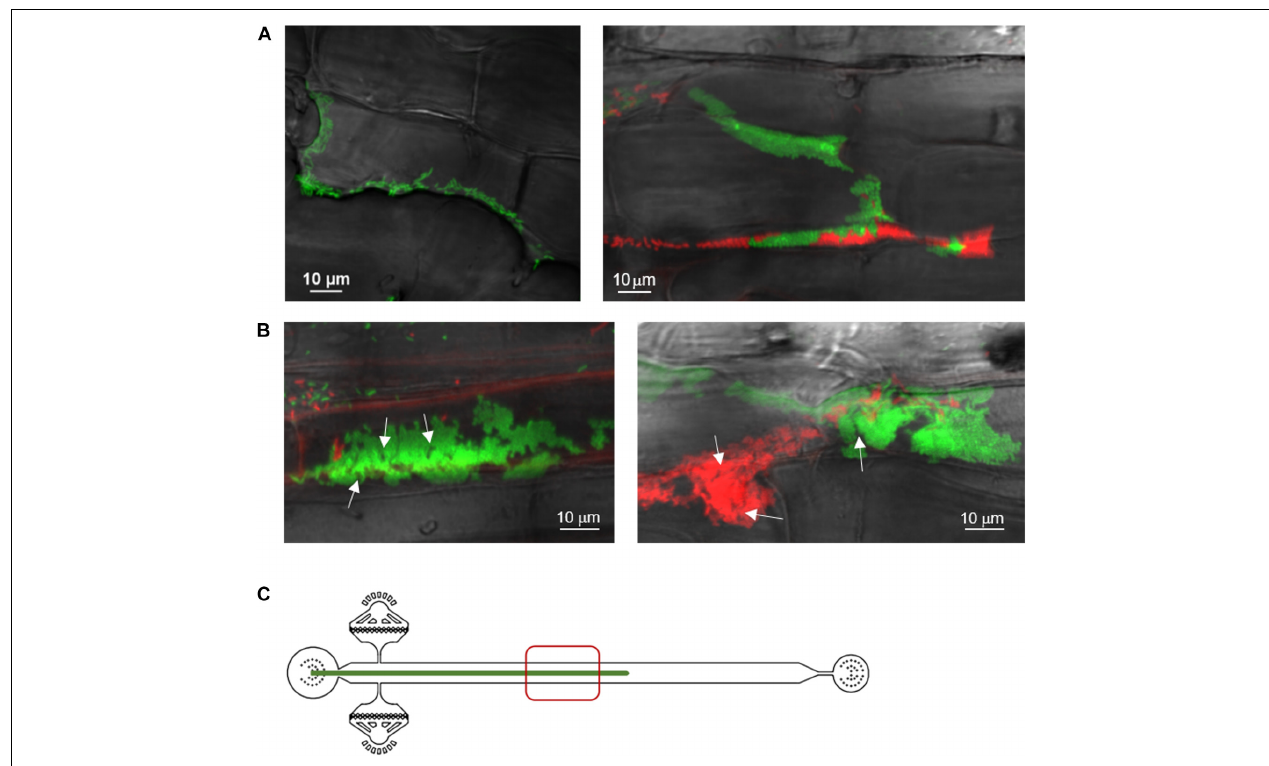
FIGURE 3 | Spatial and temporal colonization of aspen primary roots by P. fluorescens in the RMI-chip. P. fluorescens SBW25 strains expressing dsRed or mNeonGreen were co-inoculated on aspen roots growing in the RMI-chip. (A) After 3 days, bacterial cells colonize aspen root surface by filling intercellular spaces (left panel) and adhering to plant cell surfaces (right panel). (B) After 13 days, SBW25 cells formed spatially segregated red and green long patches of cells that correspond to dense biofilm-like assemblies. Typical of mature biofilms, some internal void spaces and channels are indicated by arrows. (C) Schematic representation of a root in the RMI-chip with the zone (red square) scanned by the microscope to observe the bacterial